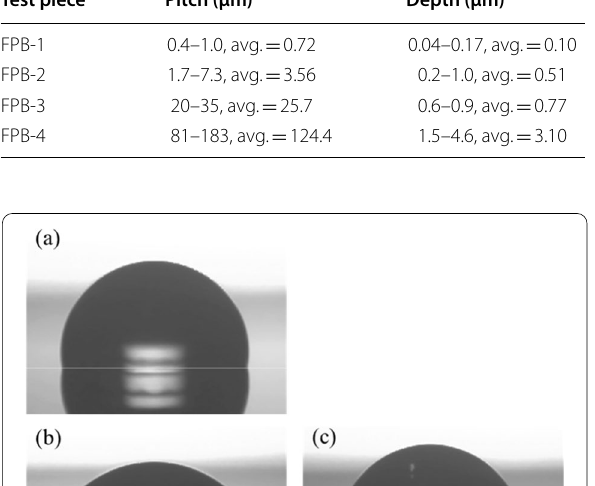
65.5°, c FPB-2, = 92.3° =